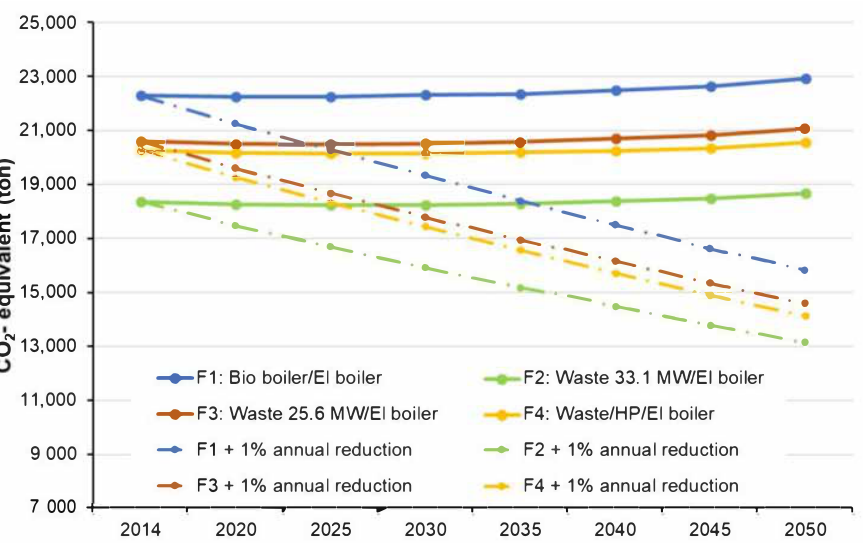
Figure 13. CO 2 emissions with a 1% annual reduction in CO 2 factor for electricity production